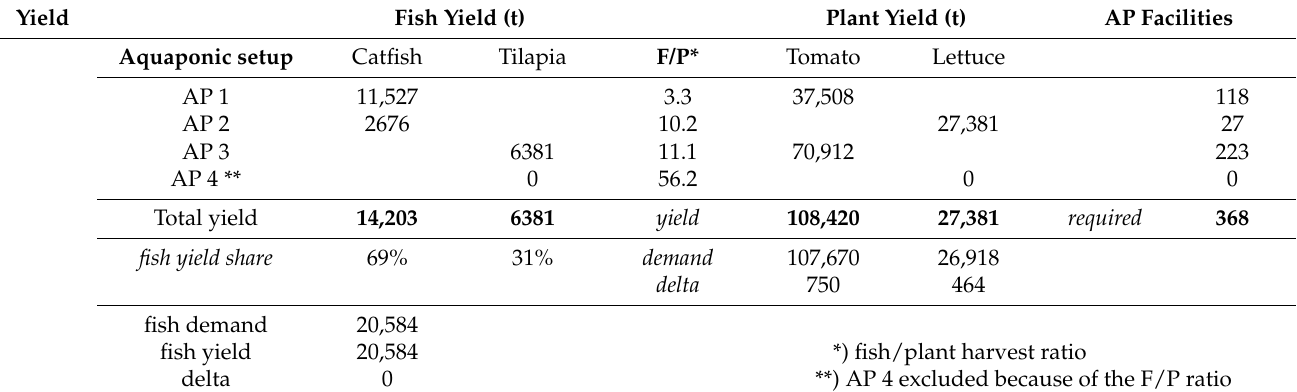
Table 4. Upscaled-AP scenario: The proposed annual yield of catfish, tilapia, tomato, and lettuce per aquaponic setup; Number of AP facilities required to achieve this